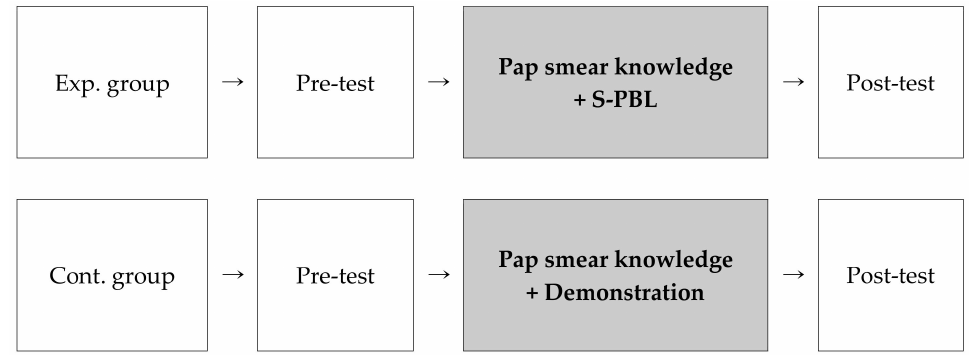
Figure 2. Research design. Exp. group = experimental group, Cont. group = control group; S-PBL = simulation problem-based